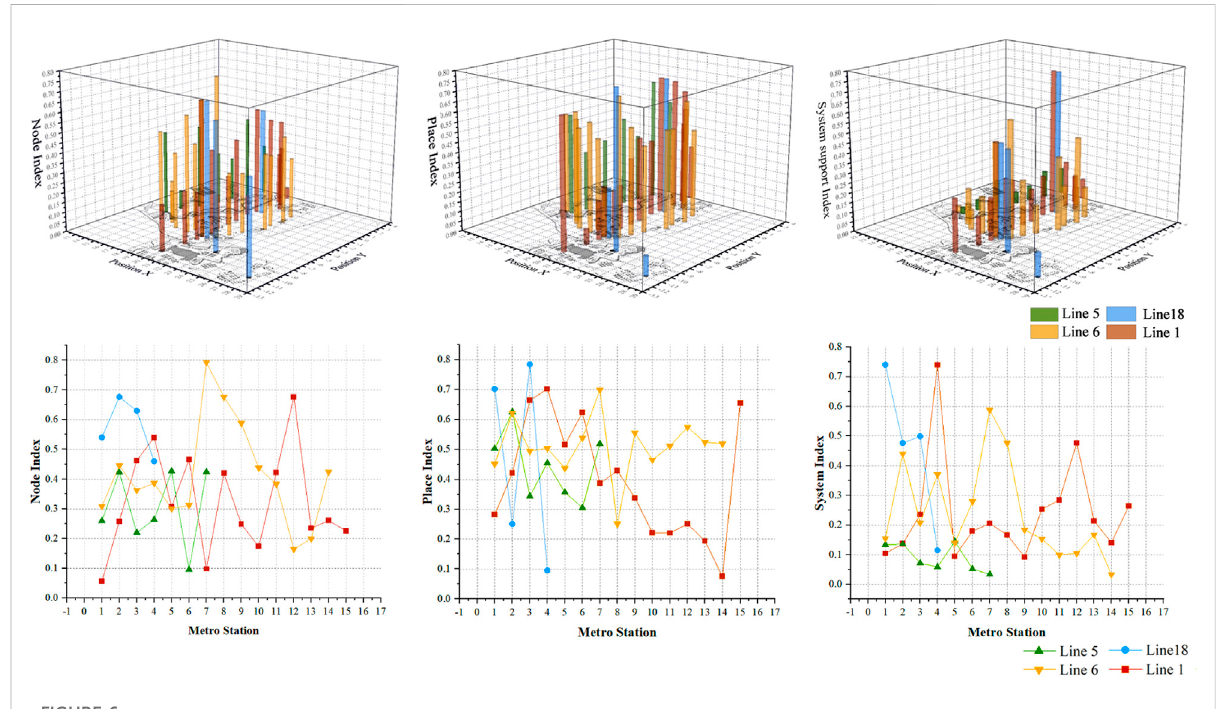
FIGURE 6 Node, Place, and System Support Indexes for each subway line.